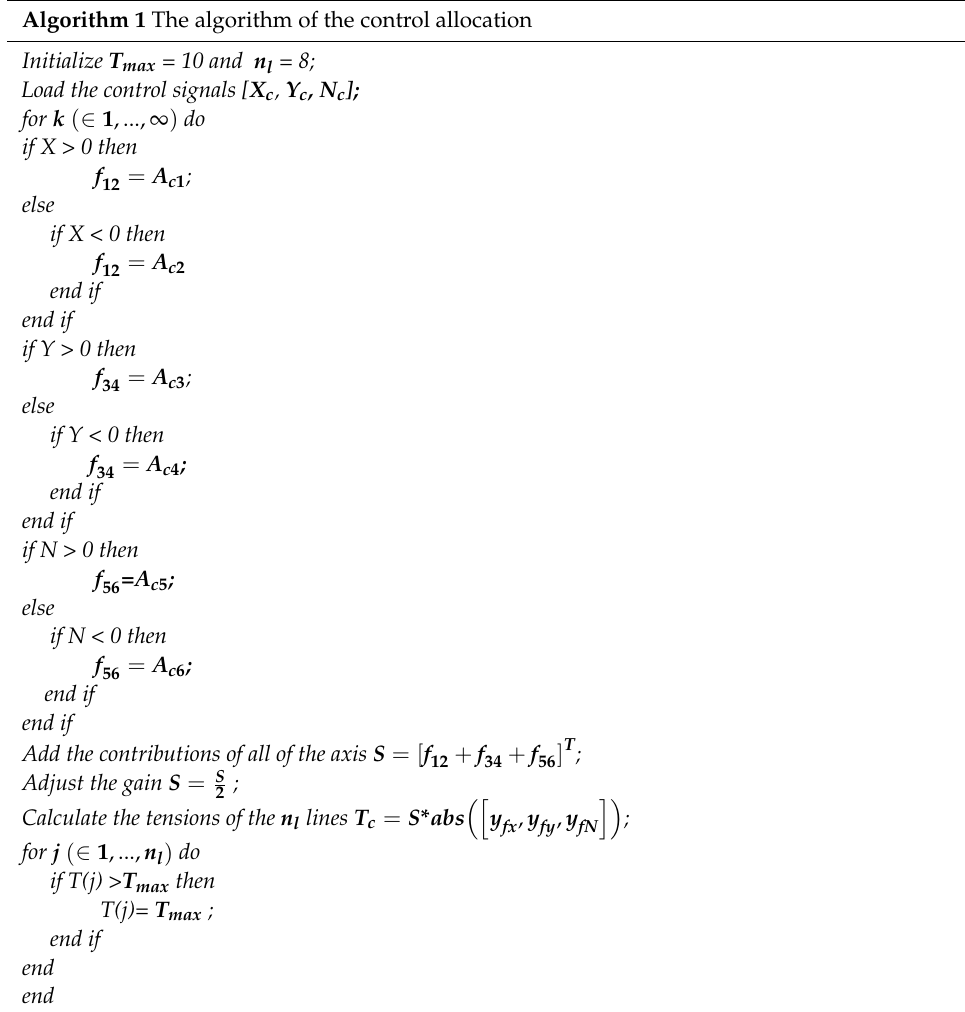
Algorithm 1 The algorithm of the control